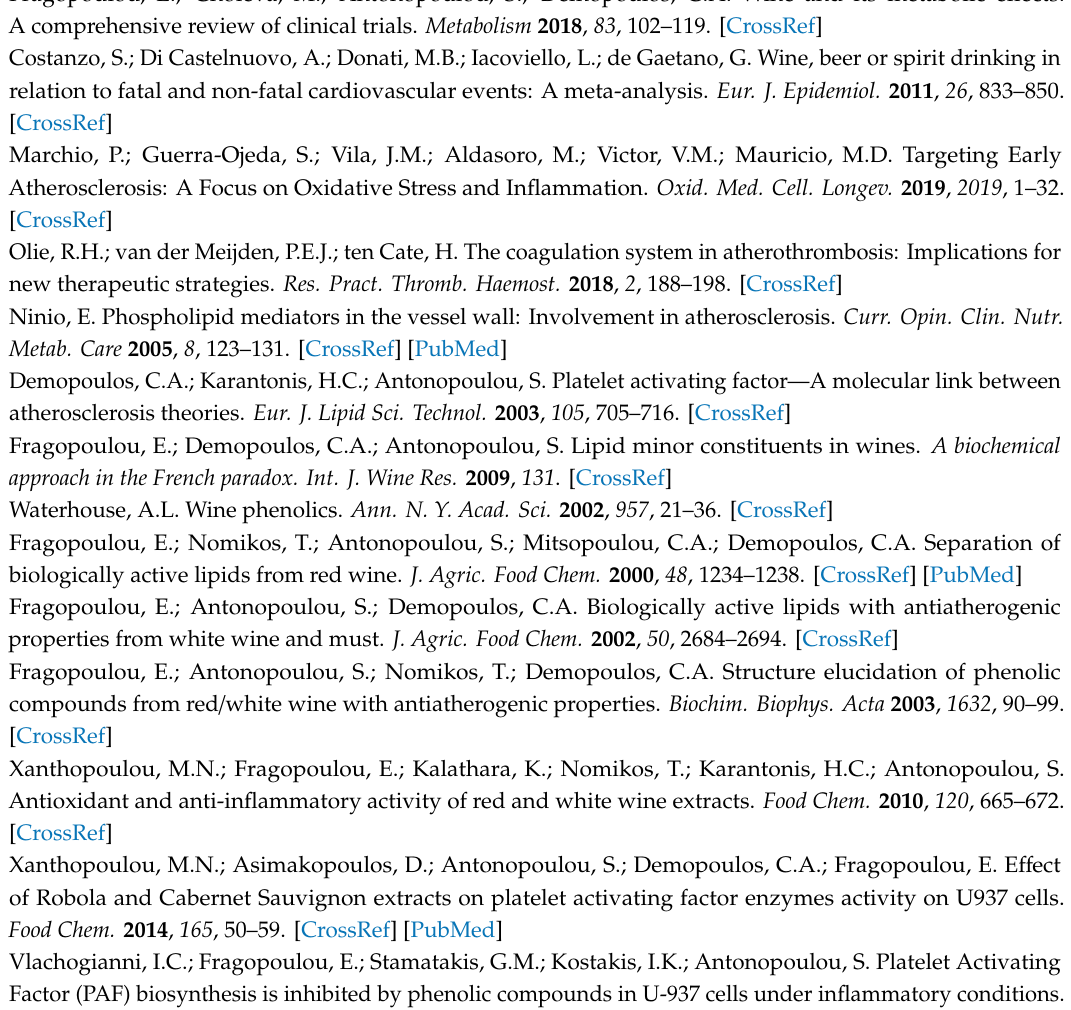
per variety, Table S2: Anti-oxidants assays in wine extracts per variety, Table S3: Anti-platelet activity of the extracts per variety, Table S4: Anti-inflammatory activity of the extracts per